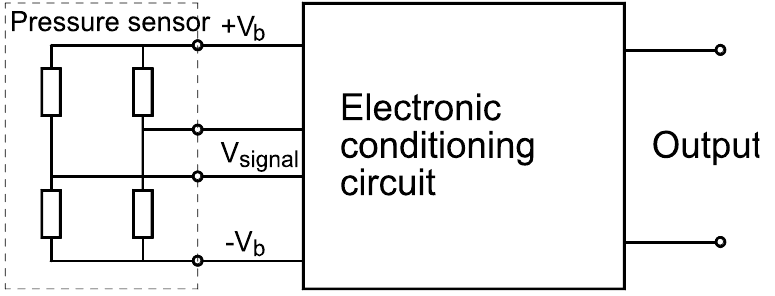
Figure 4. The piezoresistive sensing element is connected to the electronic conditioning